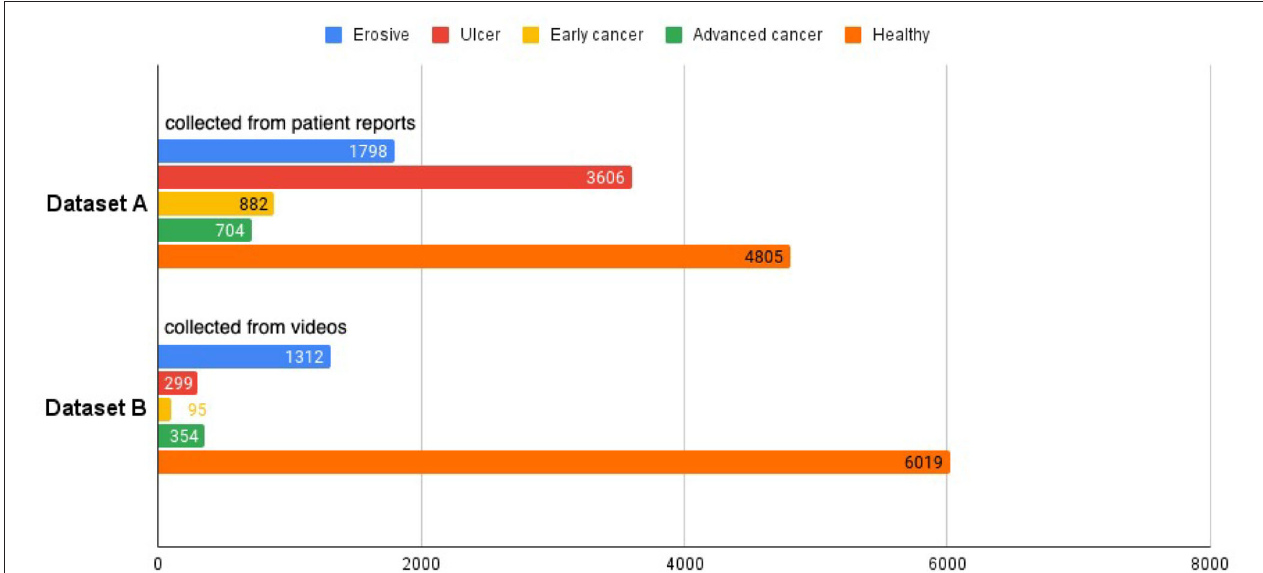
FIGURE 2 | Dataset